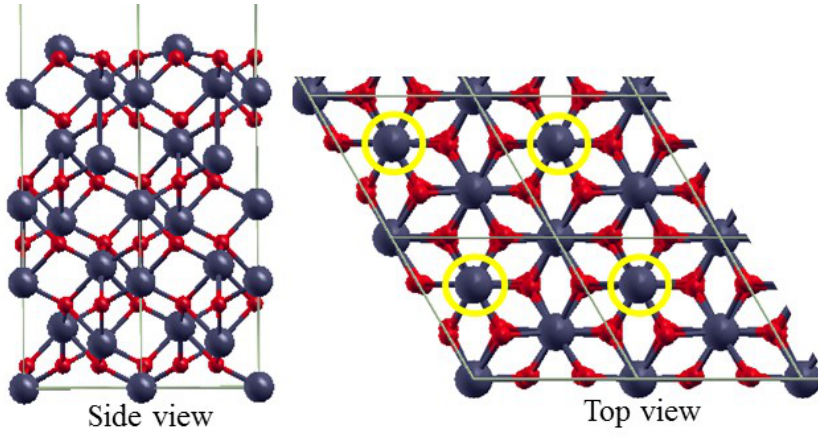
Figure 6. Schematic representation of the side and top views of the single Fe-terminated α-Fe O (0001)- p (2 × 2) surface structures. The terminating Fe atoms are highlighted in 2 3 yellow circles in the top view. Color scheme: iron = grey and O = red.